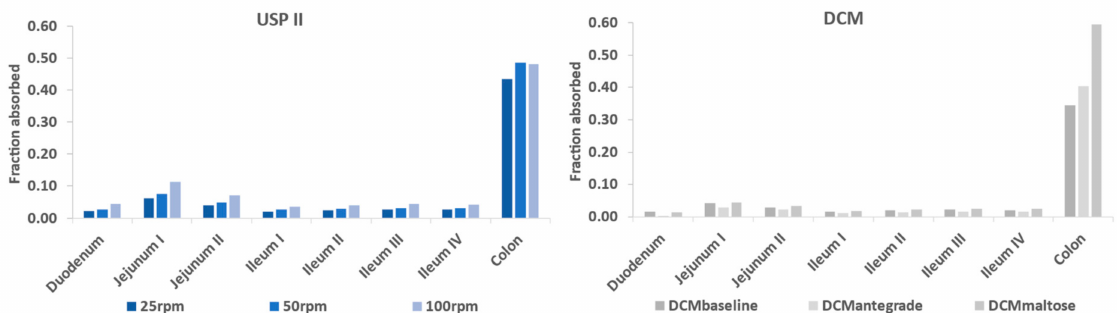
Figure 4. Simulated fraction absorbed from regional GI segments after incorporation of the in vitro dissolution profiles of the Uniphyllin Continus ® tablet (200 mg) into the Advanced Dissolution Absorption Metabolism (ADAM) model. Dissolution profiles were obtained using agitation speeds of 25, 50 and 100 rpm in the USP II and four motility patterns in the DCM, as detailed in O’Farrell et al.